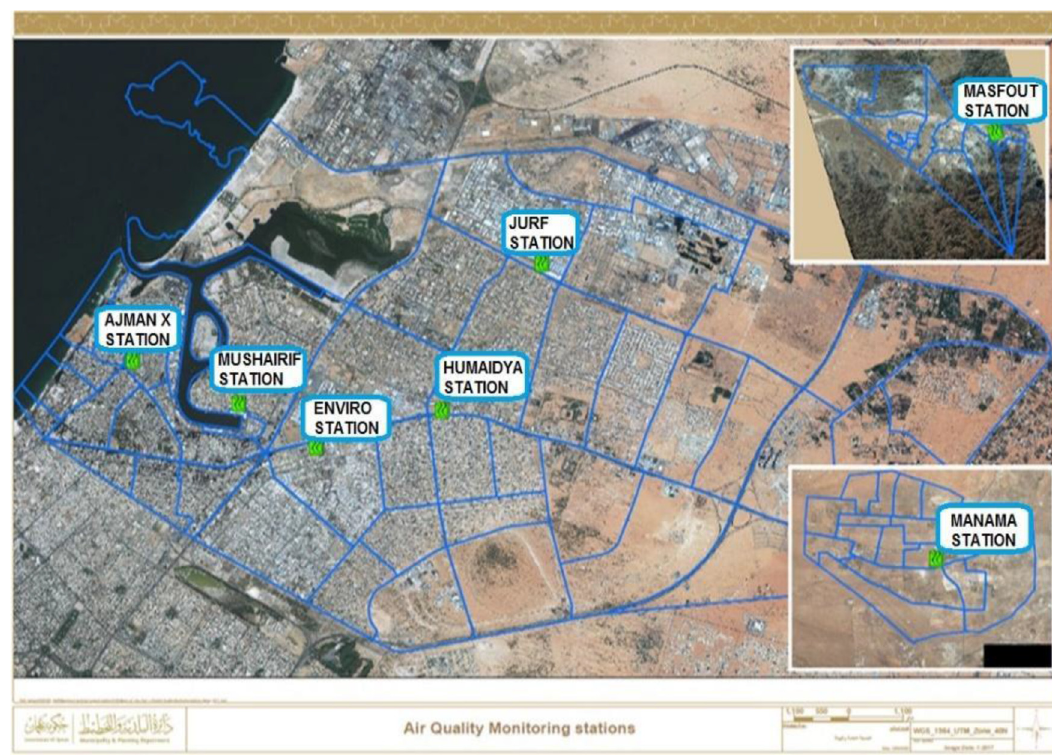
Fig. 3. The air quality stations ’ location [21].